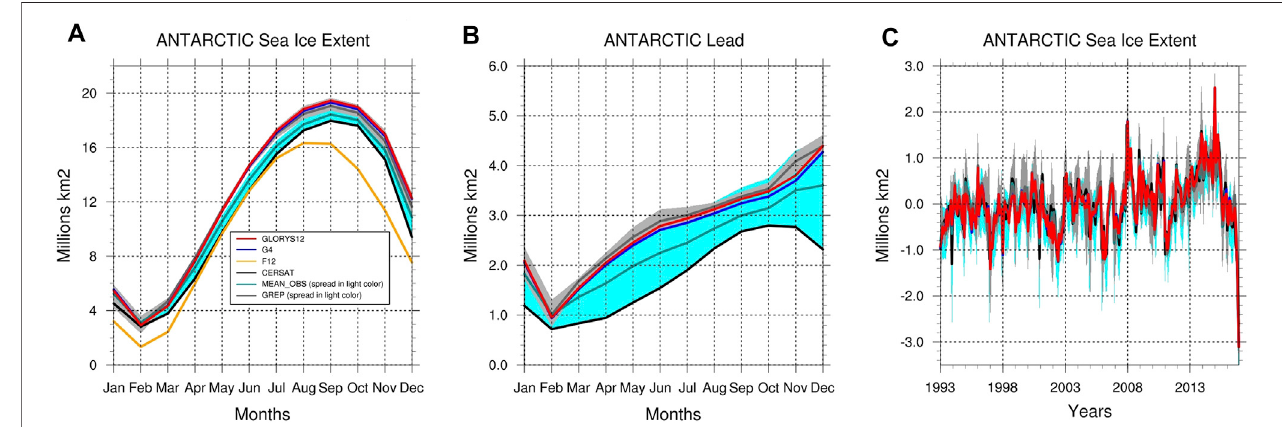
FIGURE 6 | Antarctica - Same as Figure 4 for mean seasonal cycle (1993 – 2016) of (A) Sea ice extent, (B) Leads, and (C) interannual monthly variability of sea ice extent. The simulation F12 is not shown in panels (B,C) .